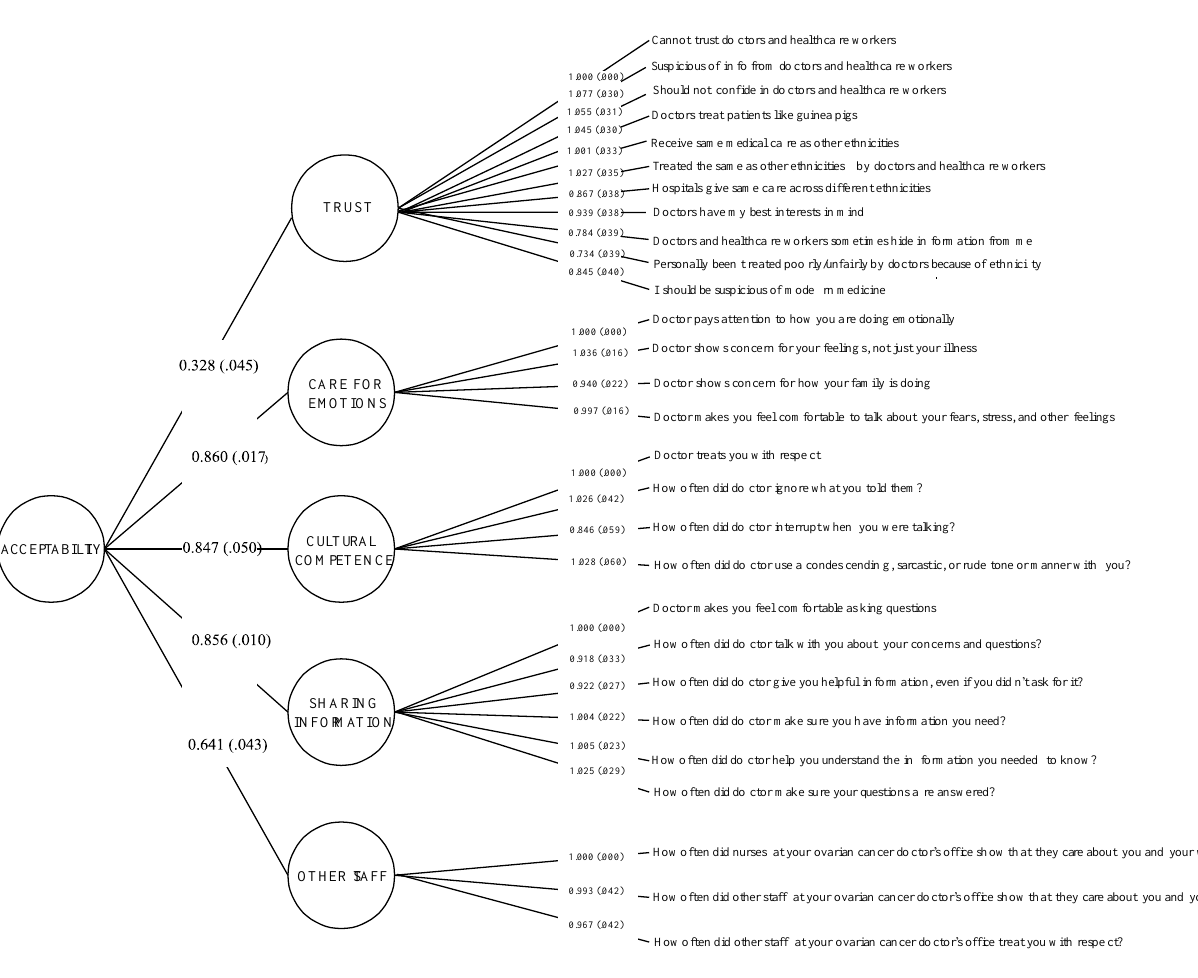
Table 3. Goodness-of-fit Statistics for the Accommodation and Acceptability Dimensions.